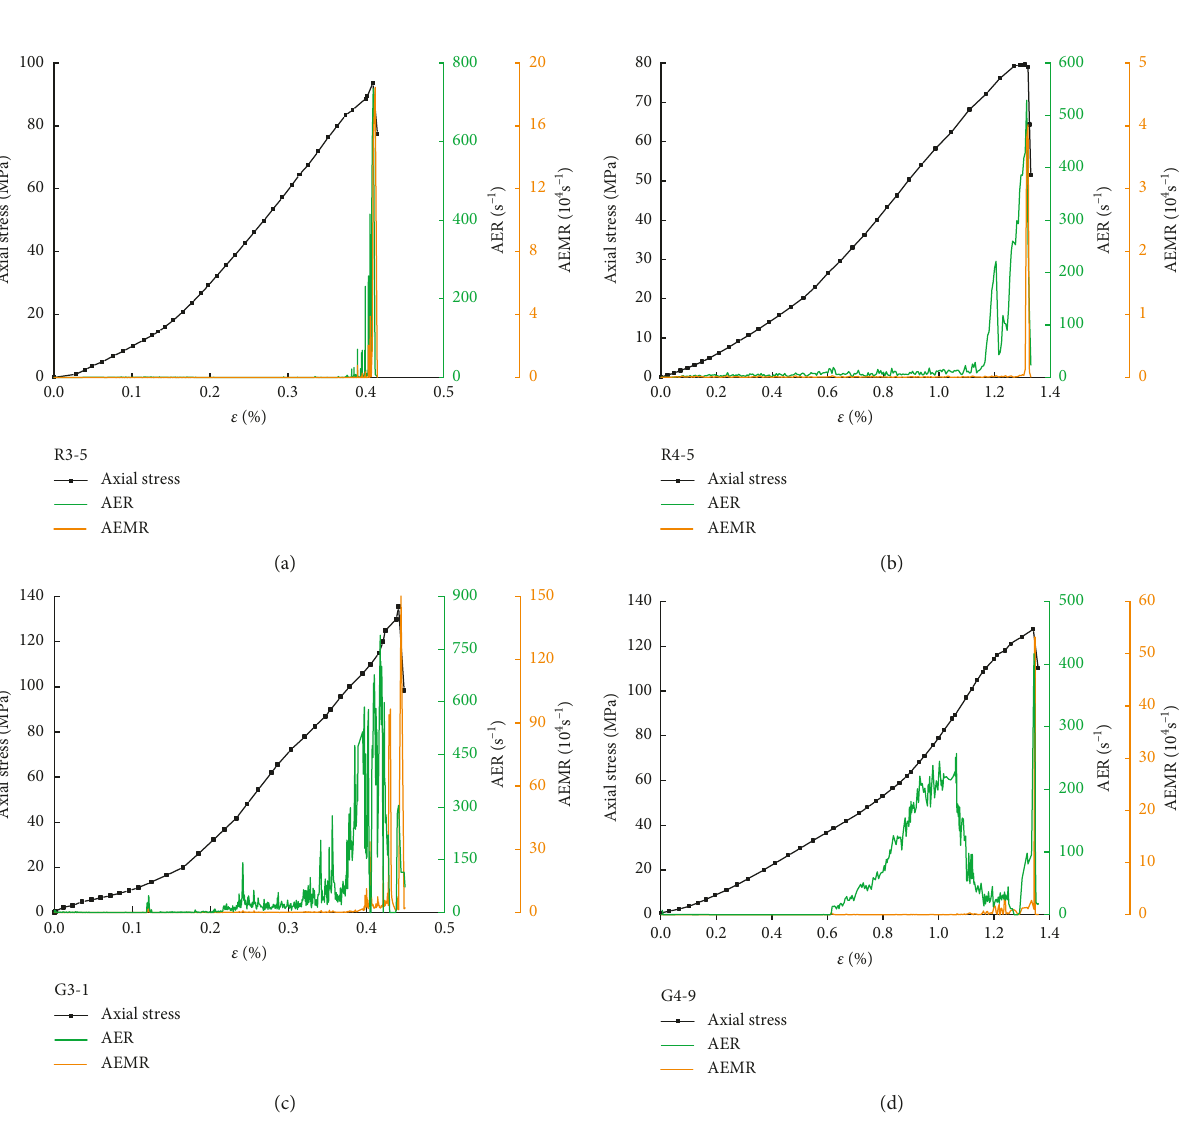
Figure 4: Failure patterns of different specimens. (a) Cubic red sandstone. (b) Cubic granite. (c) Cylindrical red sandstone. (d) Cylindrical